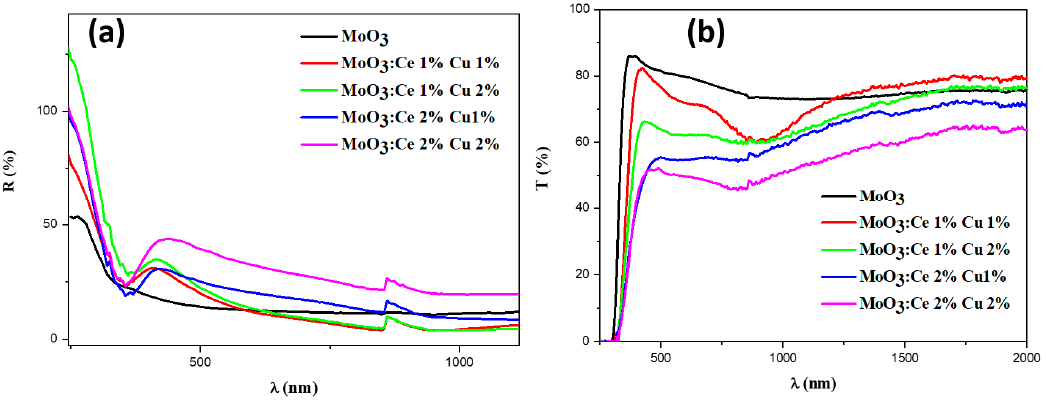
Figure 2. ( a ) Reflectance spectrum and ( b ) transmission spectra of undoped and Ce–Cu co-doped MoO 3 structures. MoO 3